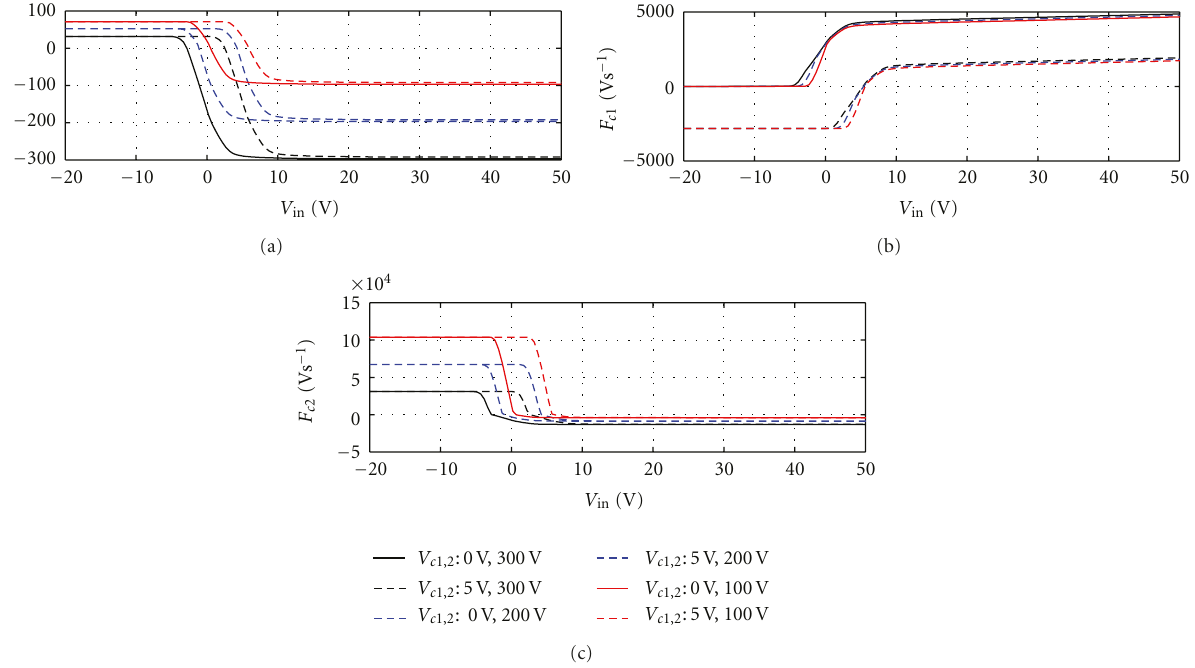
Figure 5: Approximating functions for the simulation of the system (12)—output function (a), capacitor C 1 up-date (b) and capacitor C 2 update (c) functions.